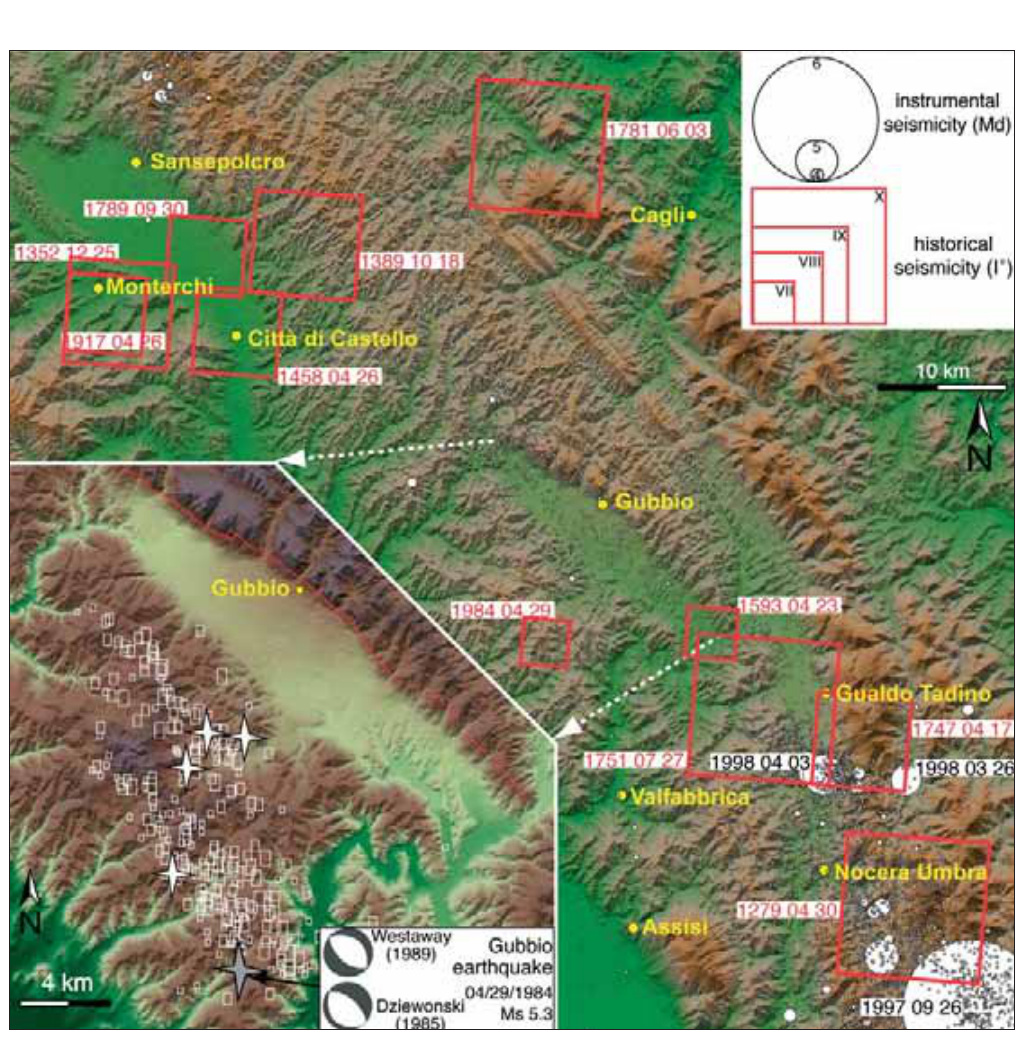
Fig. 5. Instrumental and historical seismicity of the Gubbio Basin area. Historical seismicity with intensity larger than VII MCS is reported for the period 217 B.C.-1991 A.C. (CPTI, Working Group, 1999). The inset shows the 4/29/1984 Gubbio earthquake sequence; gray star shows the mainshock, white stars show aftershocks with M > 4 and rectangles show aftershocks with M < 4 (modified after Haessler et al. , 1988). Focal mechanism parameters: